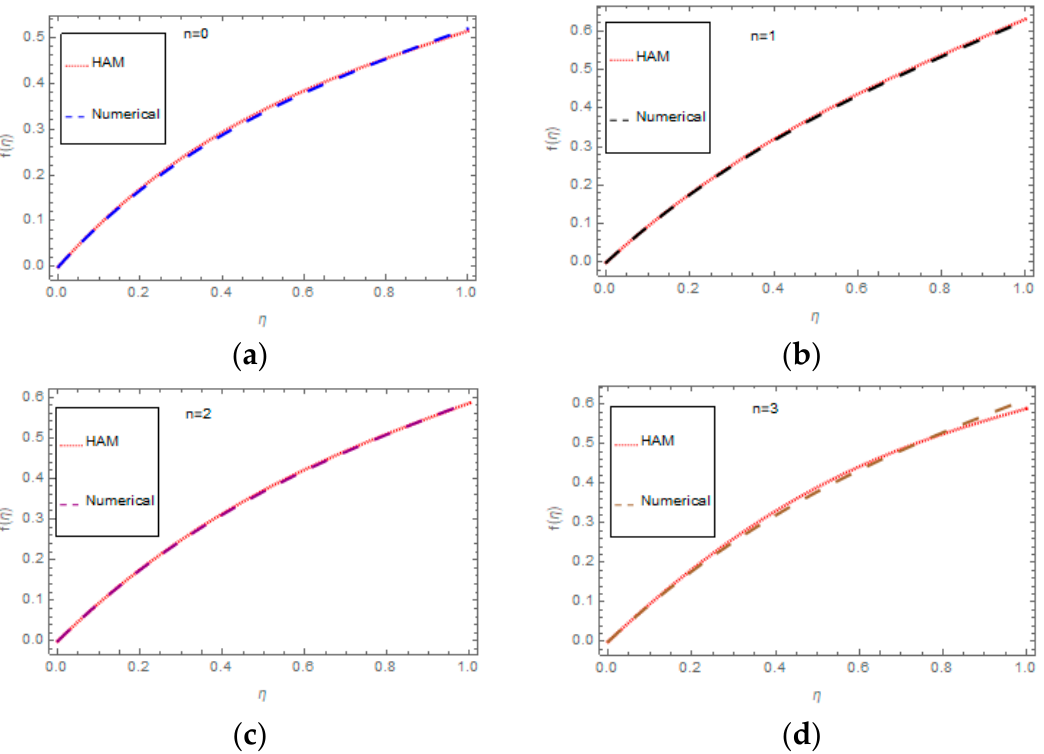
Figure 12. Comparison graphs between Homotopy Analysis Method (HAM) & numerical solution for velocity profiles f ( η ) when β = ε = 1, h = − 0.6, St = M = 0.1, ξ = 0.8 .